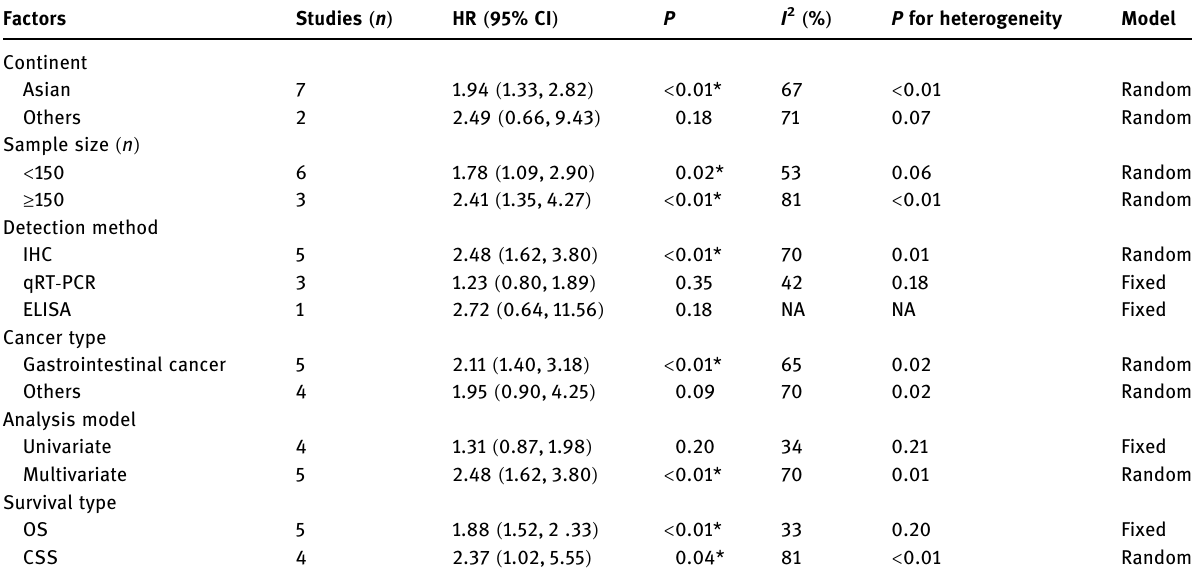
Table 2: Subgroup analysis of the association between NNMT expression and OS of cancer patients Factors Studies ( n ) HR ( 95% CI ) P for heterogeneity